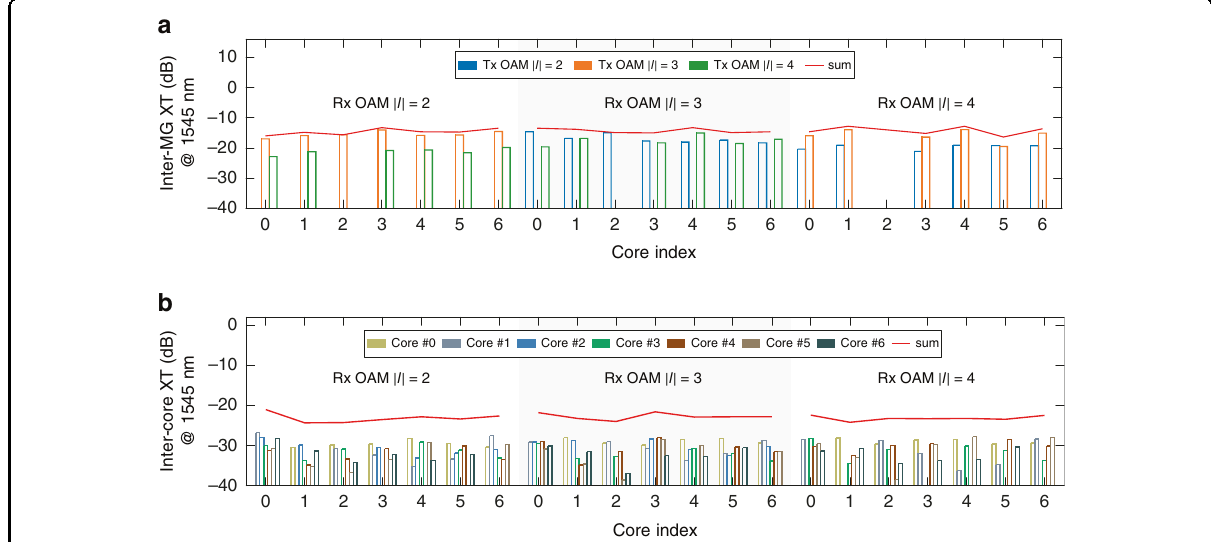
Fig. 5 The measured crosstalk of OAM MGs | l | = 2, 3, and 4 after 34 km 7-core RCF transmission. a The measured inter-MG crosstalk within the same fi bre core at 1545 nm; b The inter-core crosstalk at 1545 nm. For each core, the XT is contributed by all other 6